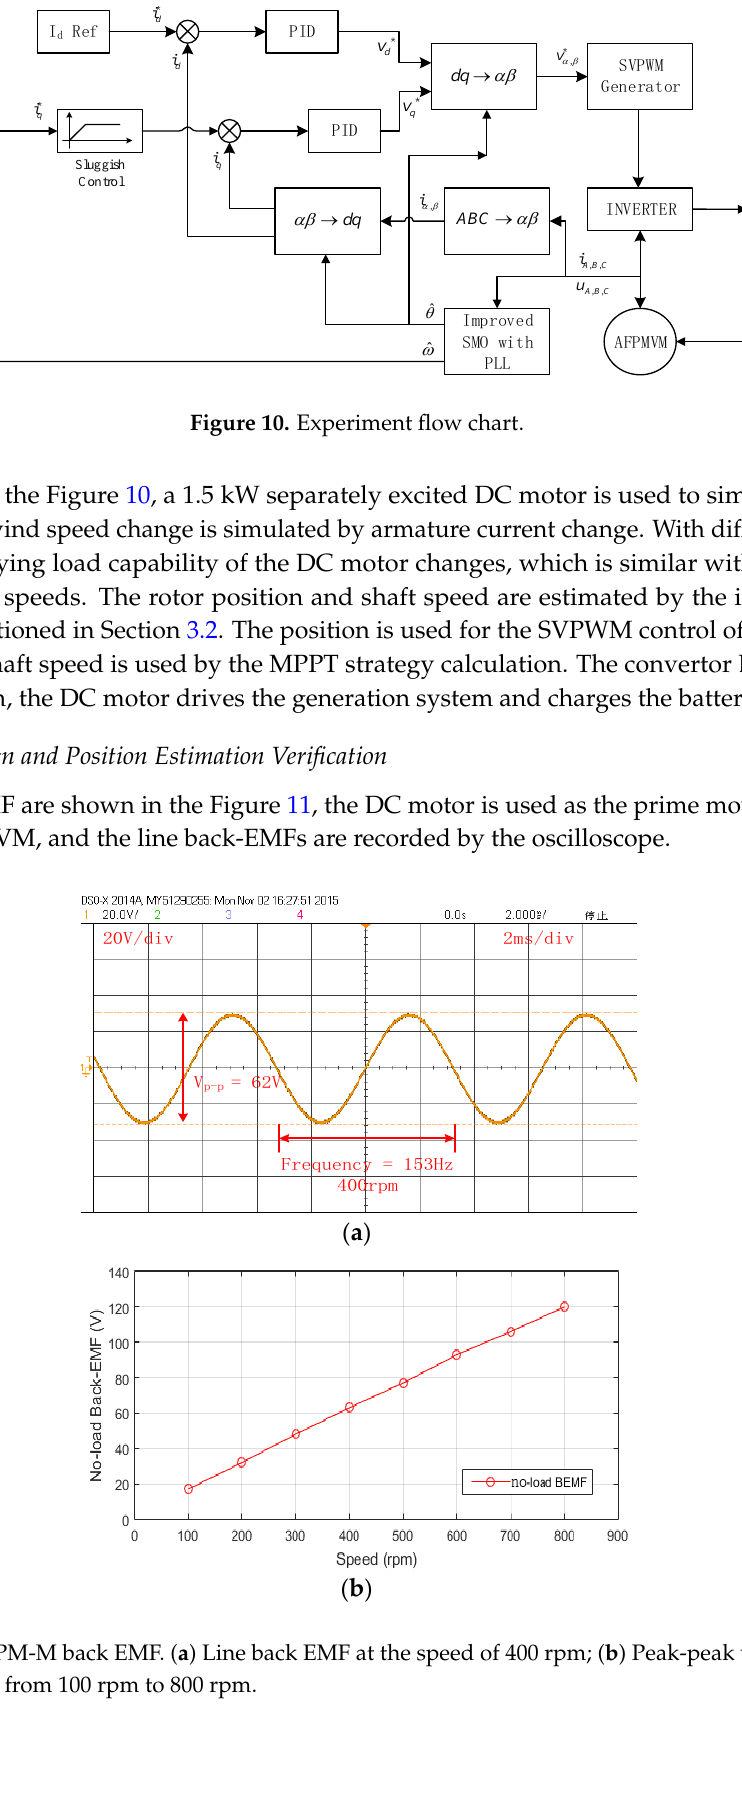
Figure 9. Proposed AFPM-VM and experimental setup. ( a ) Proposed machine; ( b ) Convertor used to drive the AFPM-VM; ( c ) DC machine, Oscilloscope and the DC power supply; ( d ) Battery system.